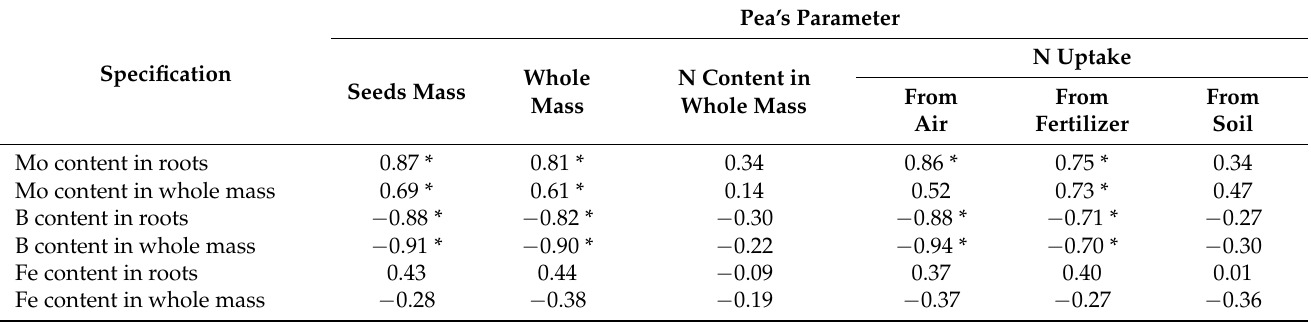
Table 11. Linear correlation coefficients between pea seed yield, the whole mass, and N uptake from different sources (presented by Wysokinski and Lozak [19]) and Mo, B, and Fe content in the roots and whole